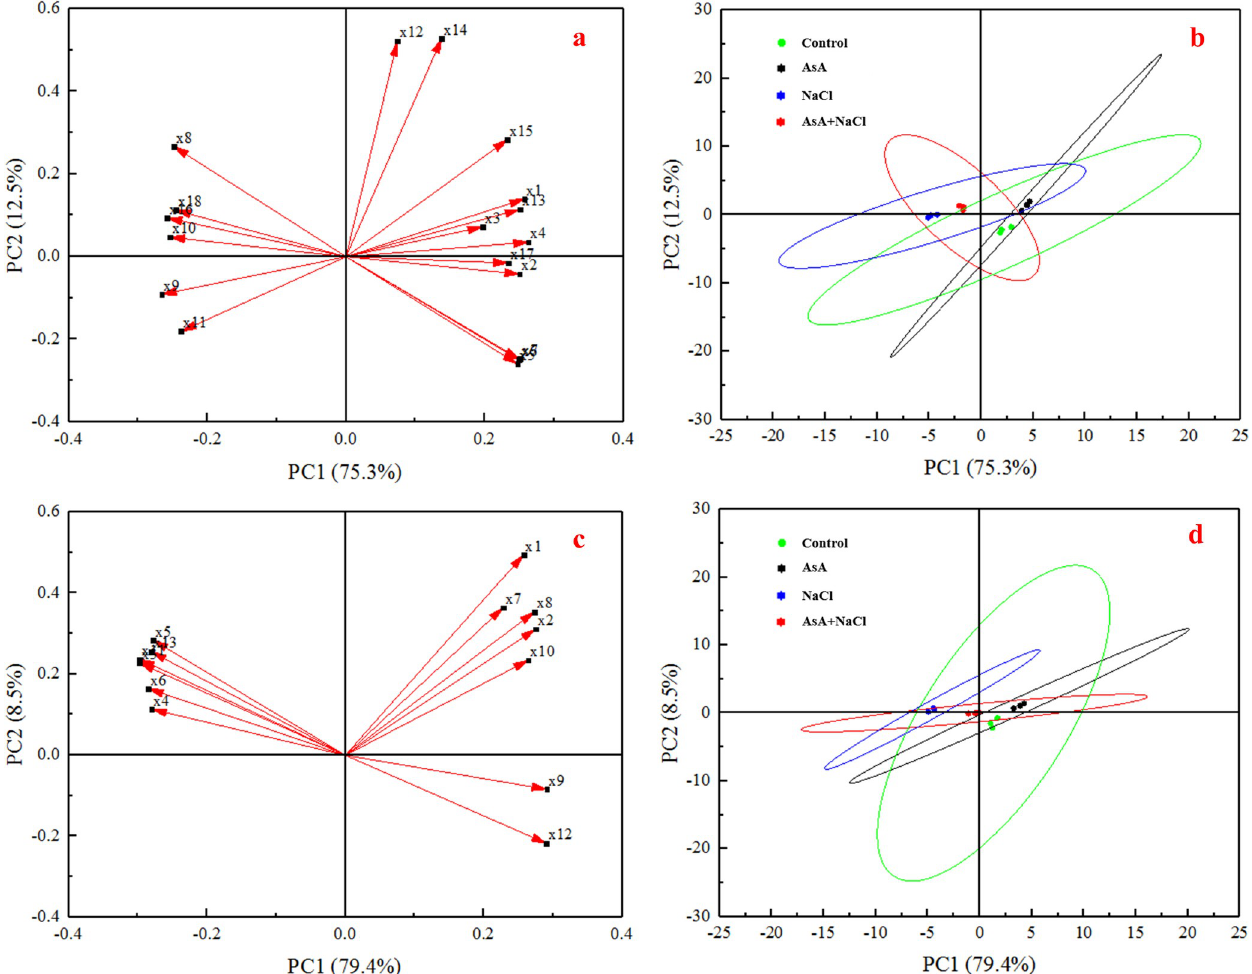
Fig 8. The loading plots (a and c) and score plots (b and d) of shoot and root, respectively. In Fig 8A, x1-x18 were shoot length, FW, DW, Chl a, Chl b, Chl a +b, Cx+c, RC, MDA, H 2 O 2 , O 2 � � , SOD, CAT, POD, AsA, Na + , K + , and Cl � of shoots, respectively. In Fig 8C, x1-x13 were FW, DW, RC, MDA, H 2 O 2 , O 2 � � , SOD, CAT, POD, AsA, Na + , K + , and Cl � of roots, respectively.